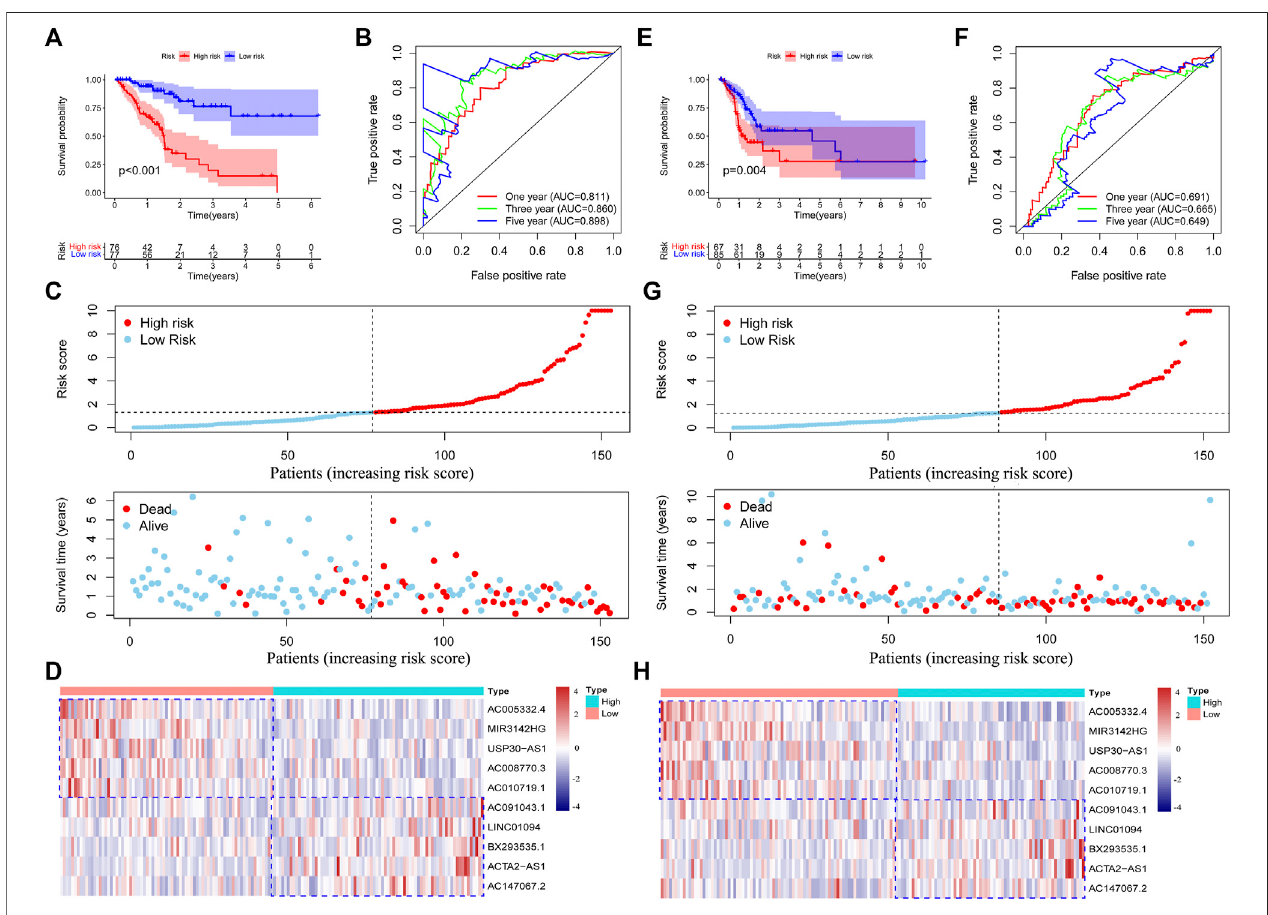
FIGURE3| Validationoftheriskmodelinthetrainingsetandtestingset.Survivalanalysisofthetrainingsetandtestingset (A,E) .Roccurveswereplottedtoassess the accuracy of the risk model in the training set and testing set (B,F) . The survival status of the patients in high-risk and low-risk groups (C,G) . The expression of the chemokine-related lncRNAs in the risk model was shown by using heatmap (D,H) . Low or high type represent the patients with low risk or high risk.